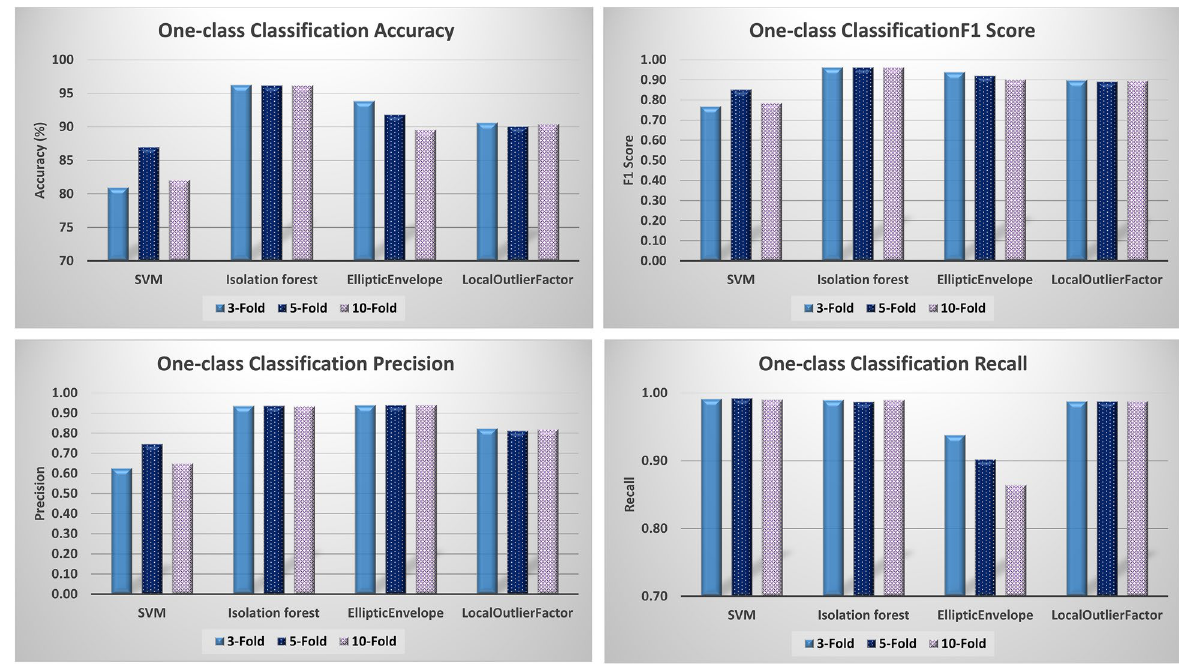
Fig. 8 One‑class classification performance evaluation